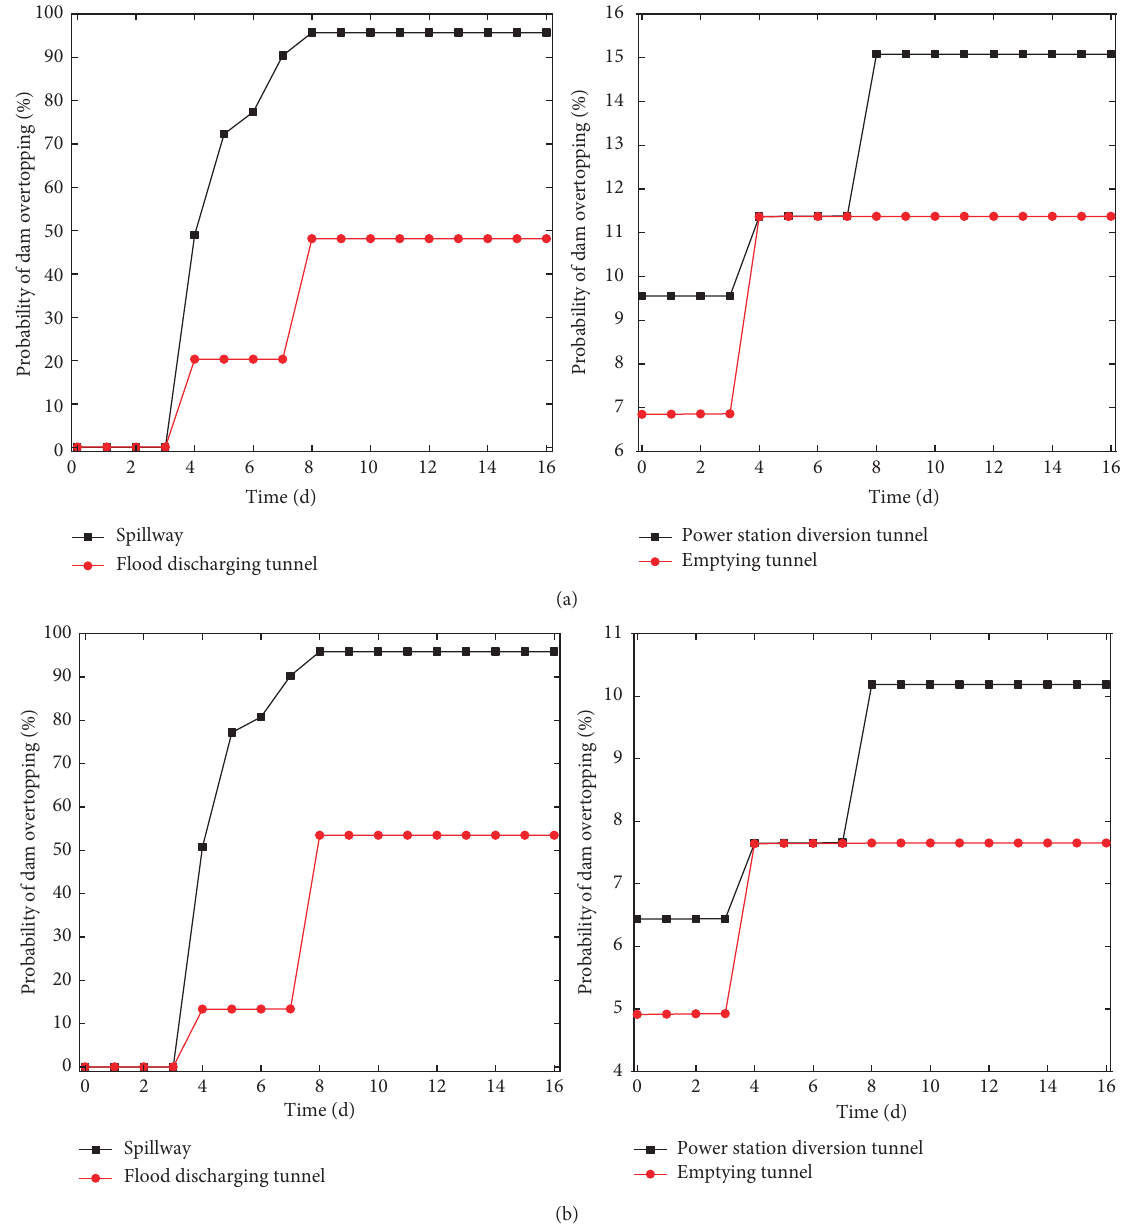
Figure 13: Variation of the probability of dam overtopping with the failure duration of each individual release structure for (a) case I and (b) case